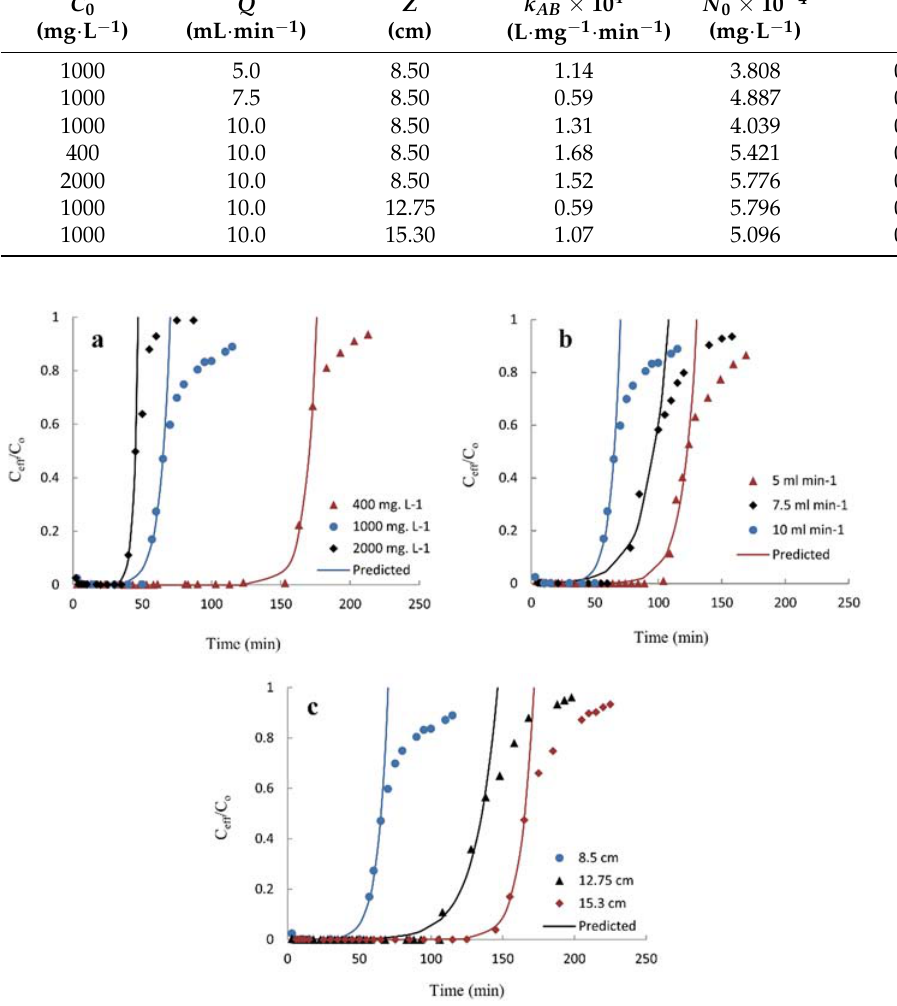
Figure 10. The experimental vs. predicted curves of breakthrough gained at dissimilar ( a ) pheno’s inlet concentrations, ( b ) phenol rates of flow, and ( c ) bed depths according to Adams–Bohart model.